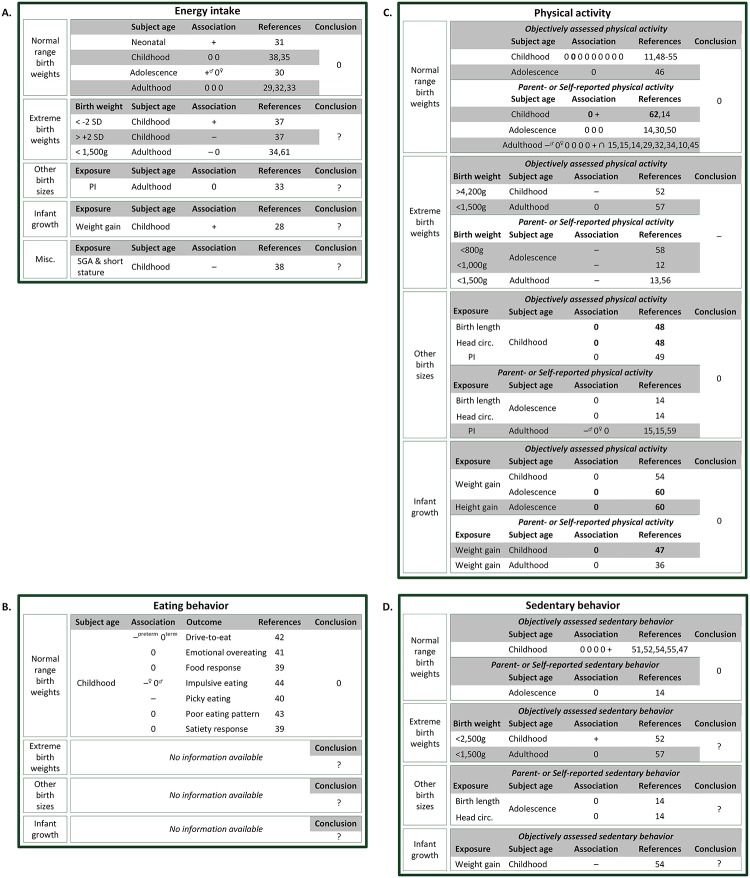
Schematic overview of all the available evidence of birth weight and infant growth with energy intake (A), eating behavior (B), physical activity (C) and sedentary behavior (D) in humans described in the literature to date.Each association is represented by + for positive,—for negative, and 0 for no association. ∩ represents an inversed U-shape association. High quality studies are marked in bold. If the association was only present for a subgroup, the subgroup is specified in superscript. The associations are subdivided by subject’s age: neonatal (age range: 0–1 mo), childhood (1 mo-12yo), adolescence (12–17 yo) and adulthood (18+ yo). The last column lists the composite score of the best-evidence synthesis: + for positive association,—for negative, 0 for no association and? for insufficient evidence. Abbreviations: SGA—Small for gestational age; circ.–circumference; PI—Ponderal Index.